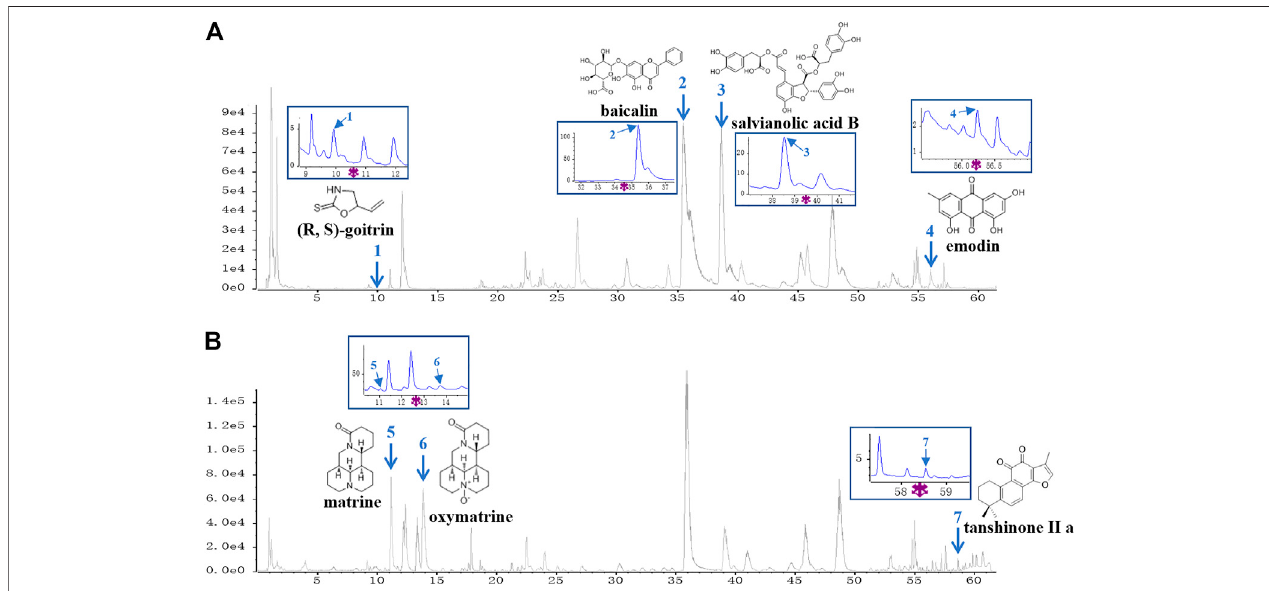
FIGURE 1 | UPLC-Q/TOF-MS analysis of Xiao-Yin-Fang. Base Peak Chromatograms of Xiao-Yin-Fang (XYF) in ESI-negative mode (A) and ESI-positive mode (B) togetherwiththechemicalstructuresandultraviolet(UV)chromatogramsofsevencomponents(1,(R,S)-goitrin;2,baicalin;3,salvianolicacidB;4,emodin;5,matrine;6, oxymatrine; 7, tanshinone II